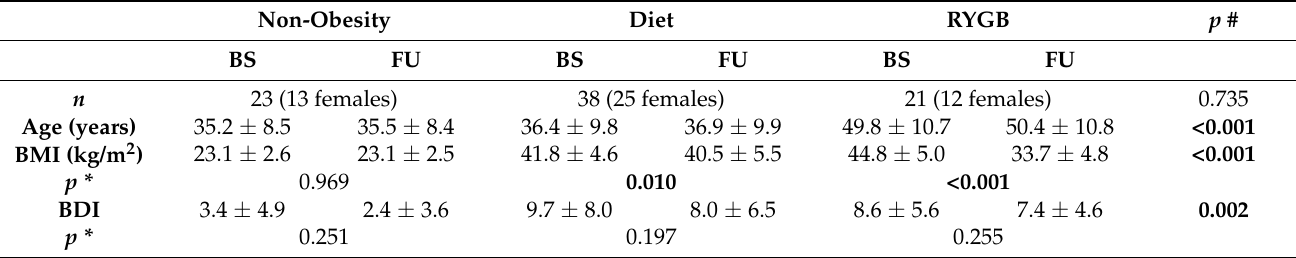
Table 1. Age, BMI and BDI values of study participants at baseline (BS) and follow-up (FU) allocated to the type of intervention.